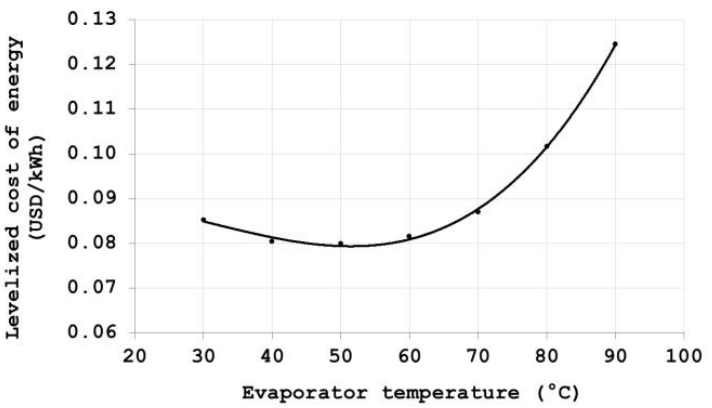
Figure 5. Cost of energy of the system as a function of the evaporator temperature. energy cost of the system proposed, LCOE, and the simple payback time, SPB, by varying the operating temperature in the evaporator (case study 1). Table 3. Levelized cost of energy and simple payback for different evaporator temperatures.